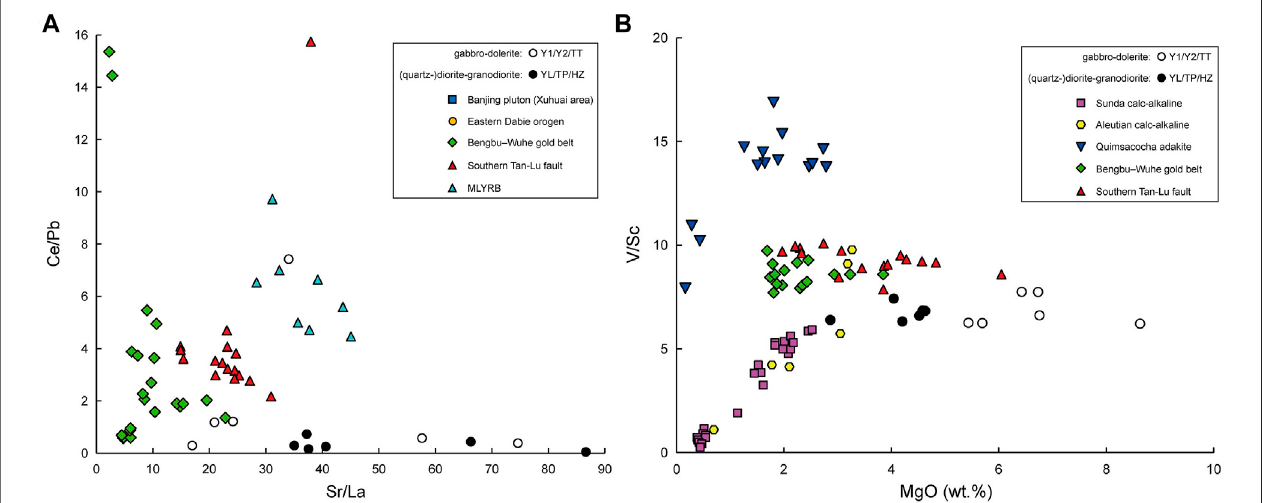
FIGURE 11 | Petrogenetic discrimination plots for the Huaibei-Linhuan intrusive rock samples: (A) Ce/Pb vs. Sr/La (after Liu S.-A. et al., 2010); (B) V/Sc vs. MgO (after Lee et al., 2005; Kamvong et al., 2014). V/Sc (cid:1) proxy for f O 2 of parental magma. Data from the ore-related porphyries from Quimsacocha (Ecuador) (Beate et al., 2001) and Dexing (Eastern China) (Wang et al., 2006) and ore-barren calc-alkaline rocks from the Sunda arc (Reubi and Nicholls, 2004) and Aleutian arc (Jicha and Singer, 2006) are also shown for comparison.